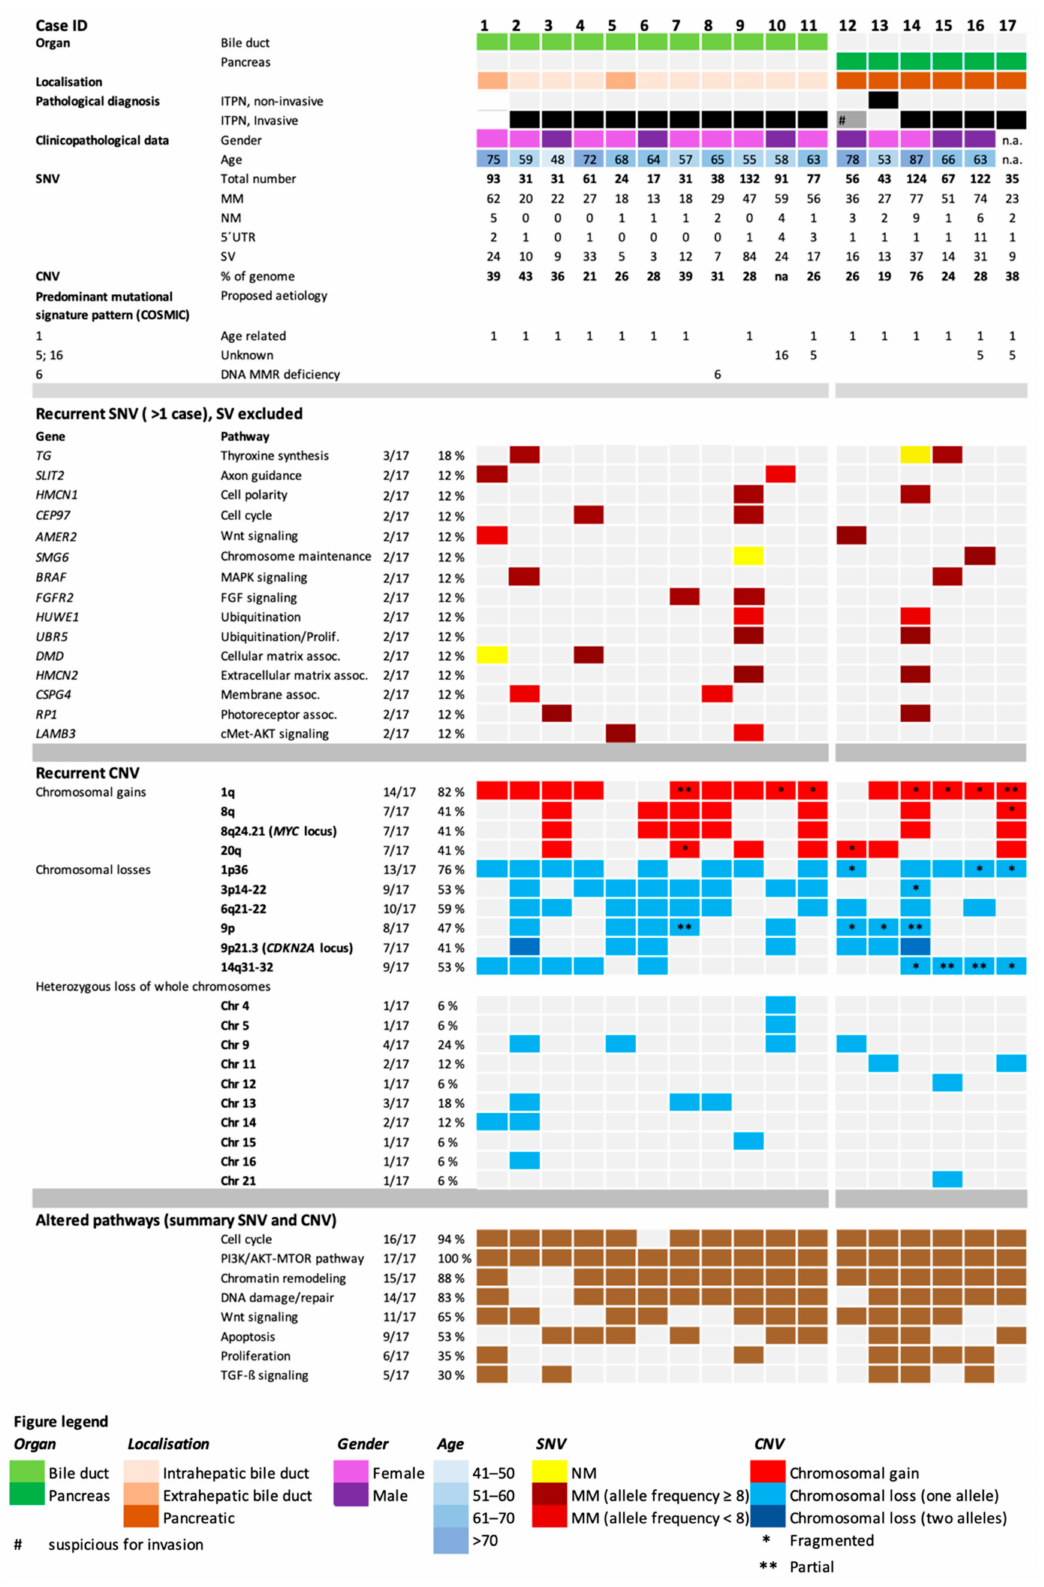
Figure 3. Oncoplot with clinicopathological features of individual patients and detailed molecular findings of whole exome sequencing (WES), including single nucleotide variants (SNVs), copy number variants (CNVs), mutational signature patterns, and altered key pathways. MM, missense mutation; NM, nonsense mutation; 5 (cid:48) UTR, mutation in the 5 (cid:48) untranslated region; SV, synonymous